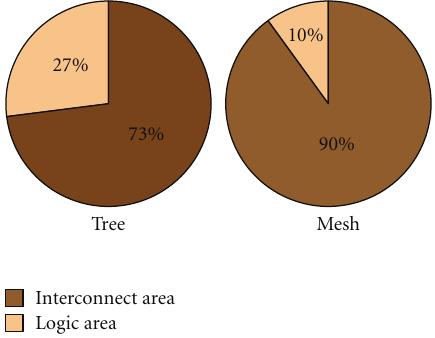
Figure 14: Area distribution between interconnect and logic blocks: Tree and Mesh